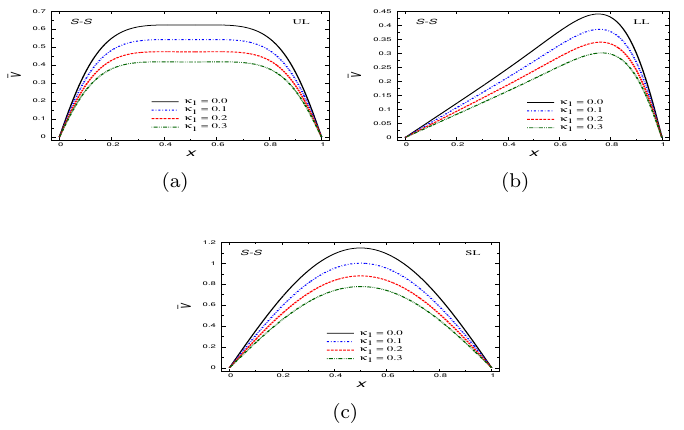
Figure 9. Effect of Winkler’s parameter κ 1 on of the distribution of angular displacement along the axial direction of a C-S CNT subjected to: (a) UL, (b) LL, and (c) SL.